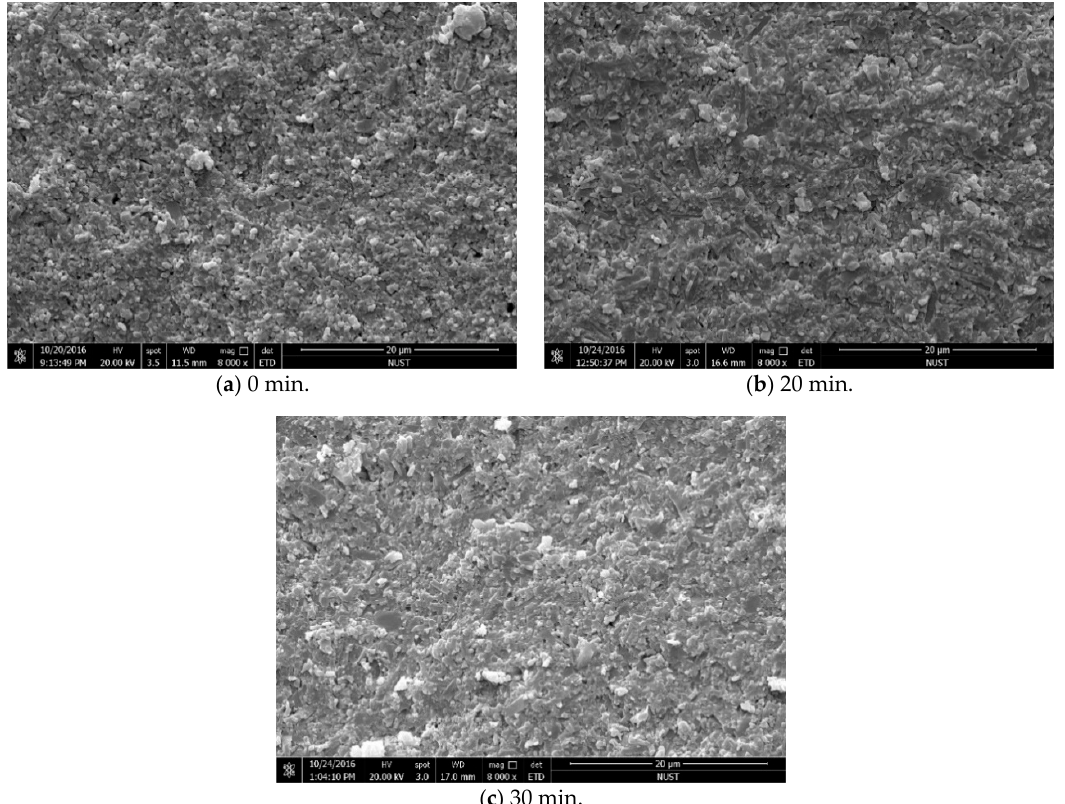
Figure 8. Effect of holding time on the relative density of the sintered Si 3 N 4 /n-SiC ceramic at 1600 °C.